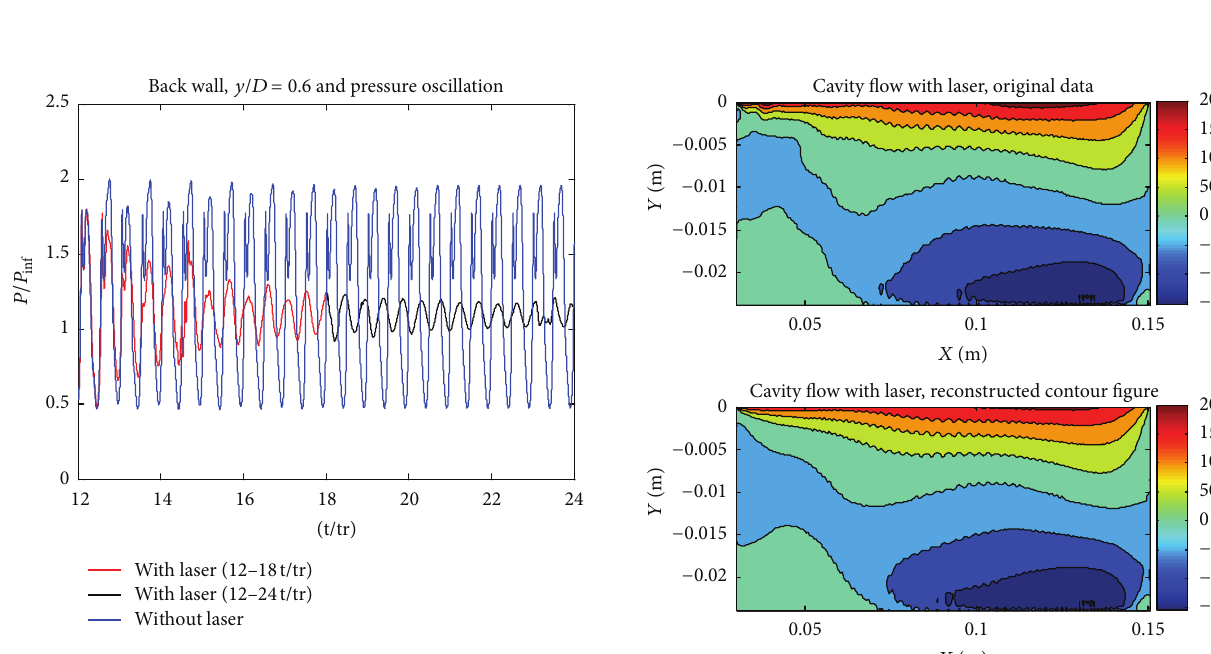
Figure 5: Pressure fluctuations for “with laser” and “without laser” cases (12–24t/tr).